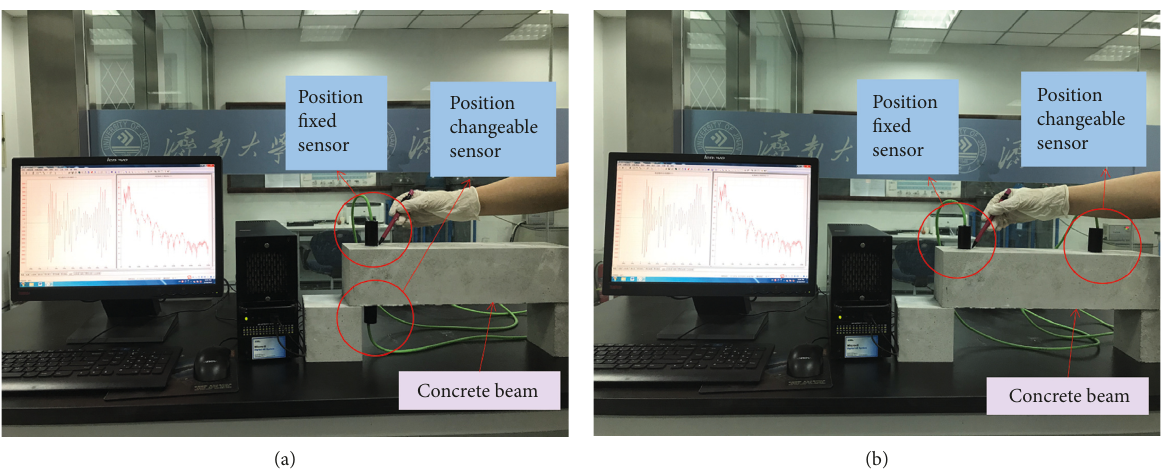
Figure 7: Photos of acoustic velocity measurement. (a) Perpendicular. (b)